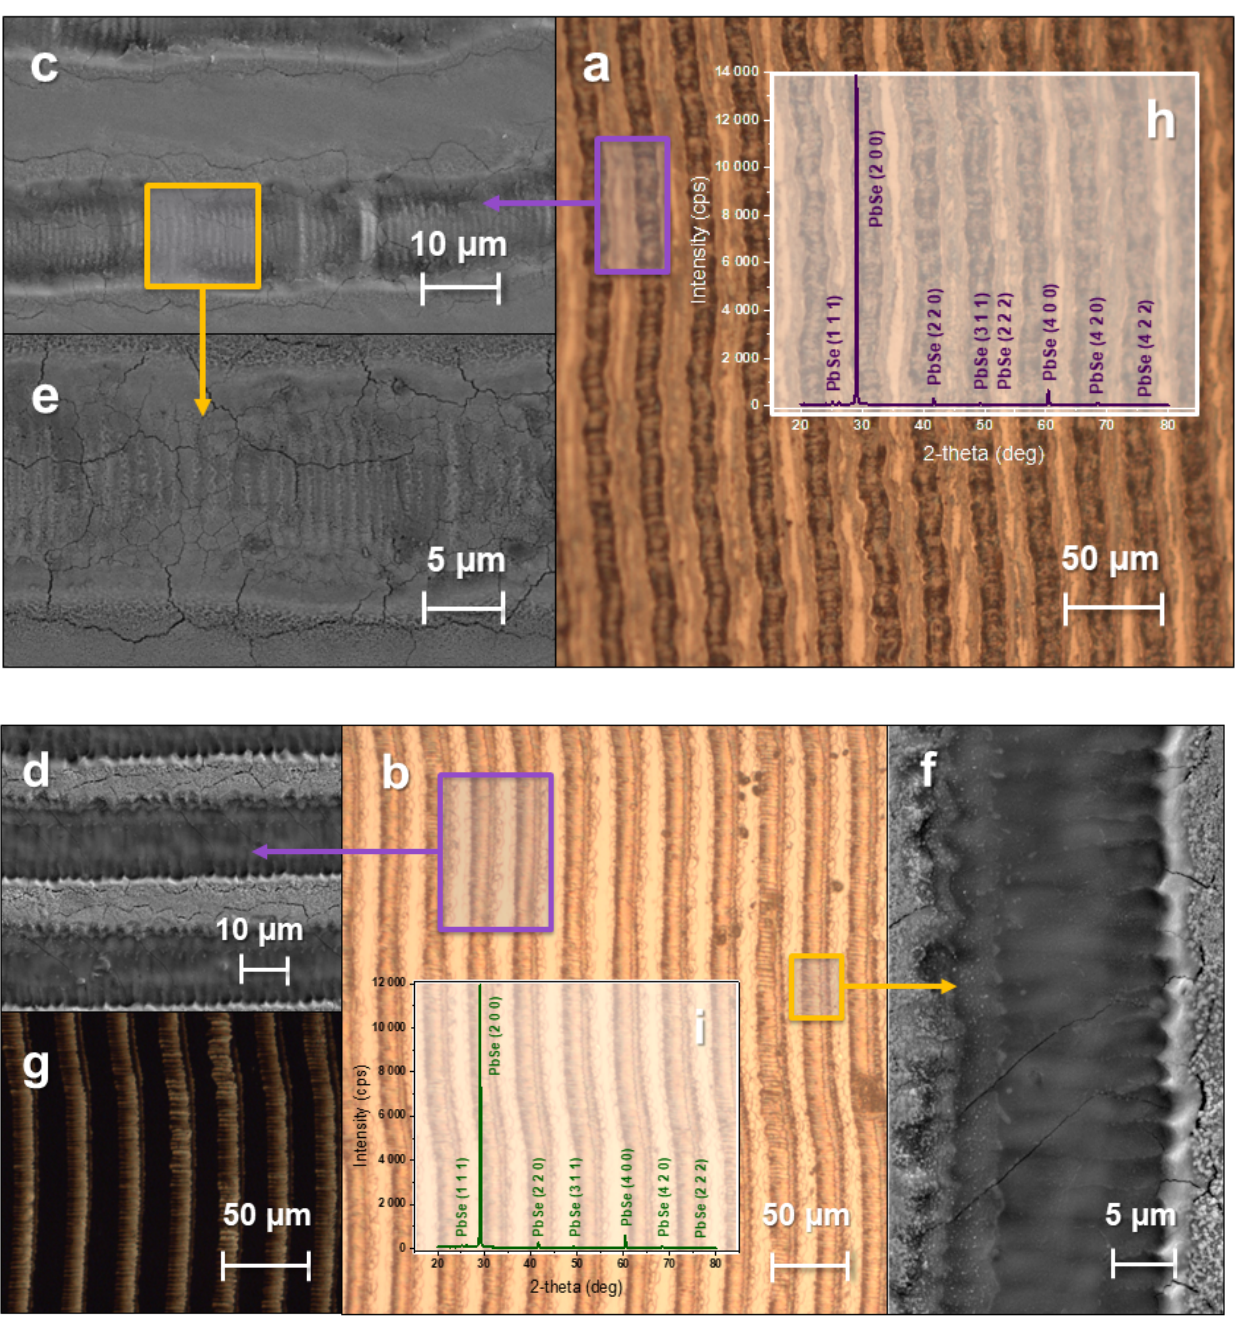
Figure 5. Images of a PbSe film obtained using optical microscopy in a bright field of reflected light: ( a ) darkening mode when modified by continuous radiation; ( b ) bleaching mode when modified by continuous radiation; in the field of transmitted light ( g ), the bleaching regime when modified by continuous radiation. Pictures of the PbSe film obtained with the SEM secondary electron detector: ( c , e ) darkening mode when modified by continuous radiation; ( d , f ) bleaching mode when modified by continuous radiation. Pictures of the PbSe film obtained using an X-ray diffractometer: ( h ) darkening mode when modified by continuous radiation; ( i ) bleaching mode when modified by continuous